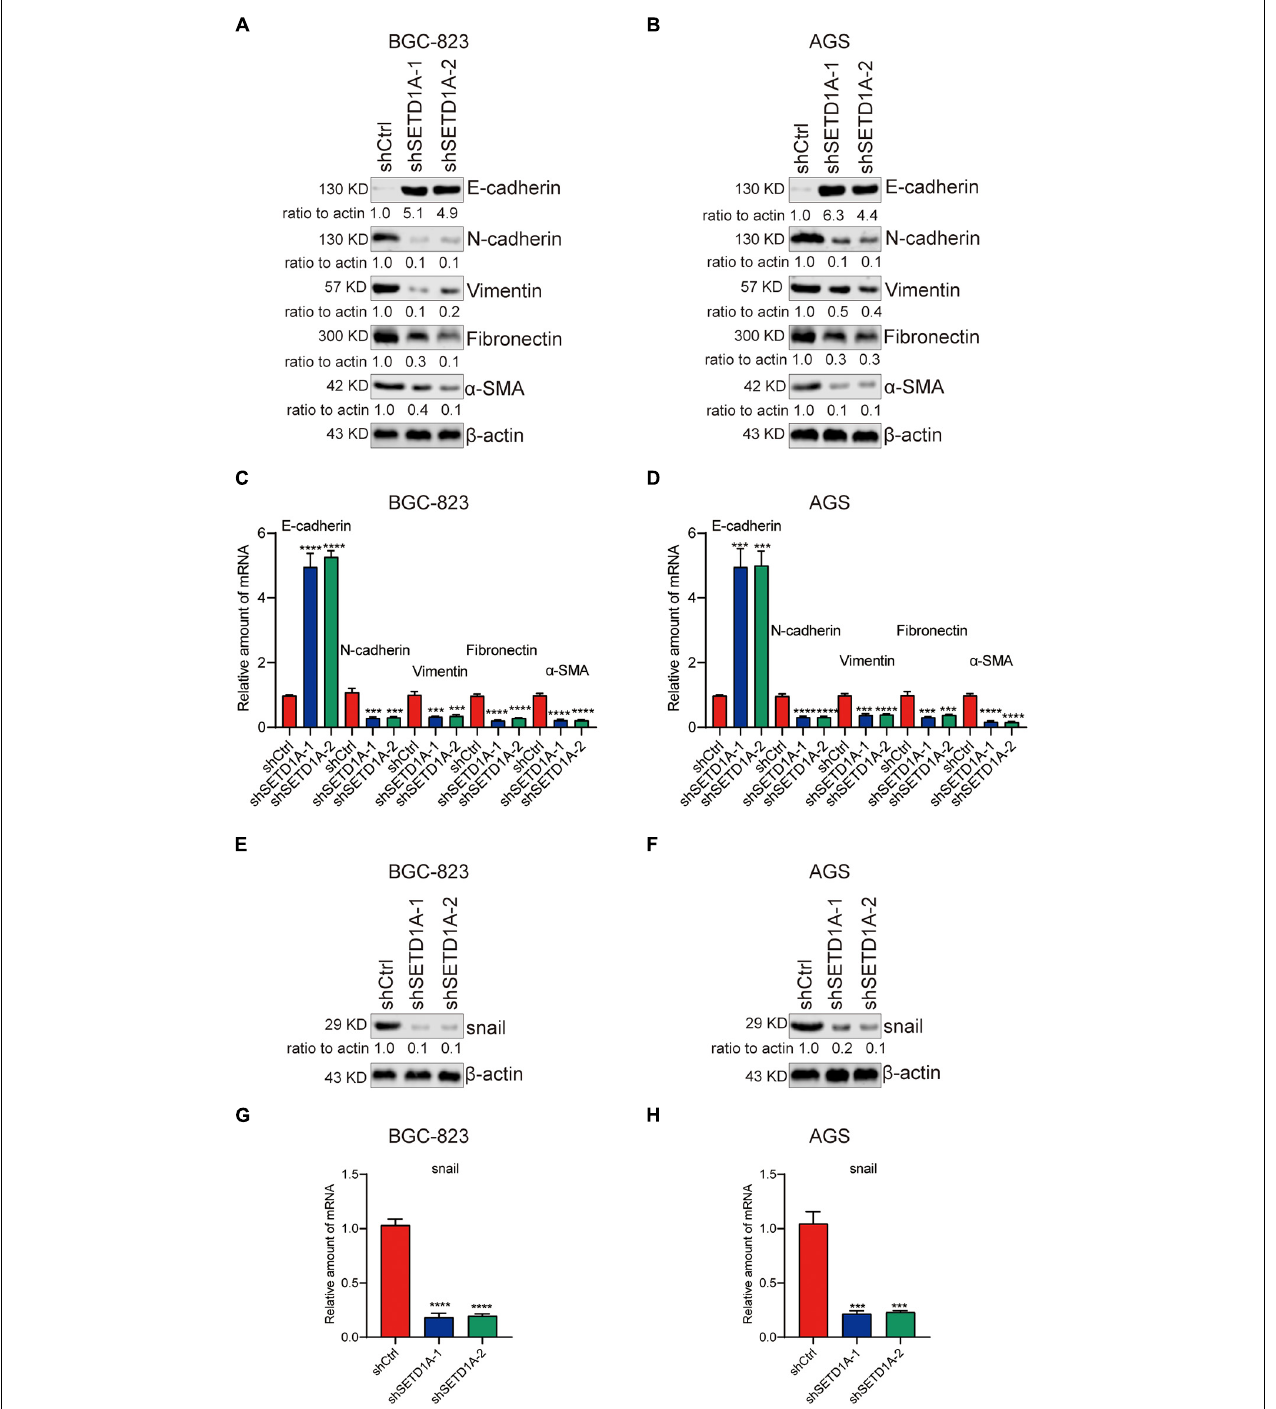
FIGURE 2 | Knockdown of SETD1A suppresses GC cell EMT. (A,B) Downregulation of SETD1A increases the protein level of E-cadherin and reduces the protein levels of N-cadherin, vimentin, fibronectin, and α -SMA in BGC-823 (A) and AGS (B) cells. Data from three replicates are shown as the means ± SD. (C,D) Downregulation of SETD1A increased the mRNA level of E-cadherin and reduced the mRNA levels of N-cadherin, vimentin, fibronectin and α -SMA in BGC-823 (C) and AGS (D) cell. Data from three replicates are shown as the means ± SD. *** p < 0.001, **** p < 0.0001 by Student’s t -test. (E,F) Downregulation of SETD1A increases the protein level of snail in BGC-823 (E) and AGS (F) cells. Data from three replicates are shown as the means ± SD. (G,H) Downregulation of SETD1A increases the mRNA level of snail in BGC-823 (G) and AGS (H) cells. Data from three replicates are shown as the means ± SD. *** p < 0.001, **** p < 0.0001 by Student’s t-